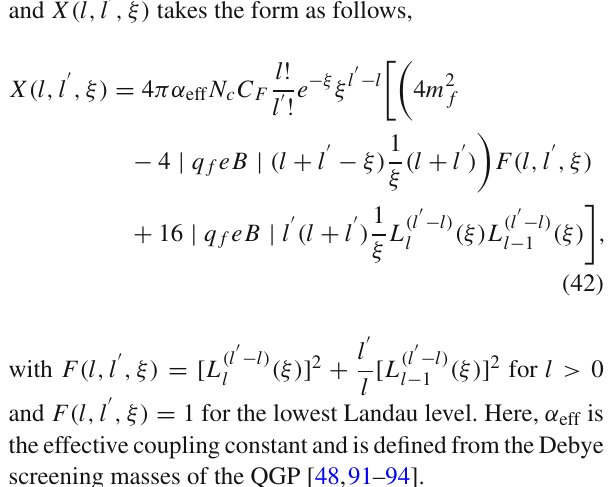
Fig. 2 The effects of HLLs on the temperature behaviour of ζ/ s at | eB |= 10 m 2 ζ/ s is comparing with the result at B = 0 π . Behaviour of of Mitra et al.